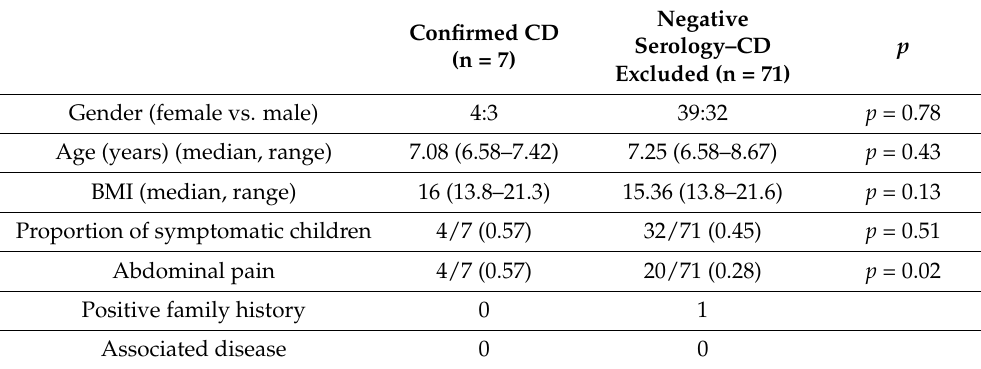
Table 2. Comparison of children diagnosed with coeliac disease (CD) vs. children with positive point-of-care test but excluded CD (negative